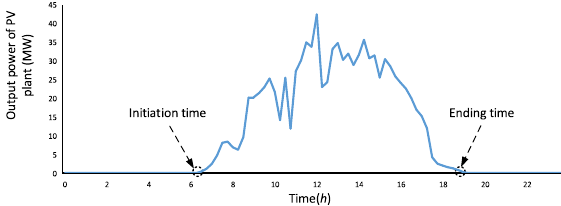
Fig. 1 Initiation time and ending time of PV